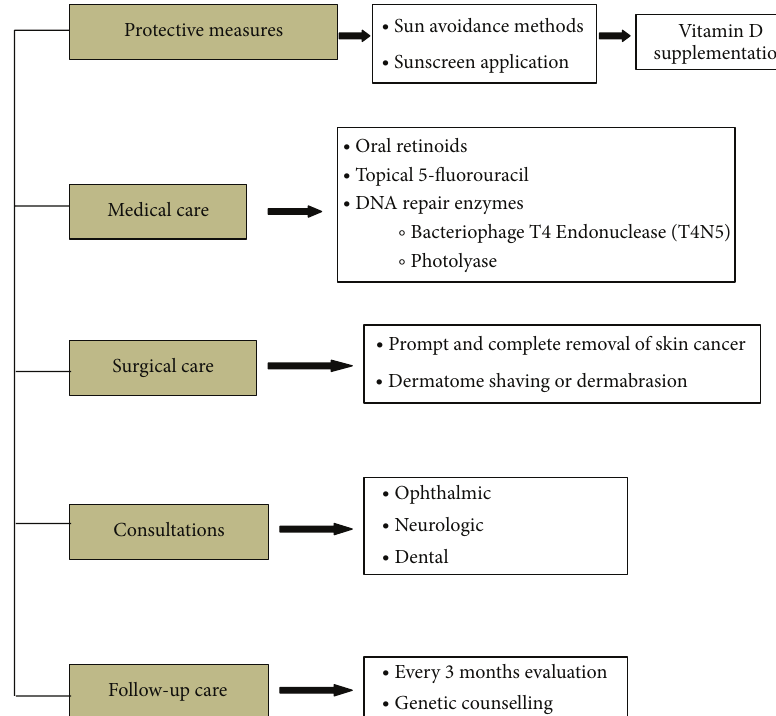
Figure 7: Treatment protocol for xeroderma